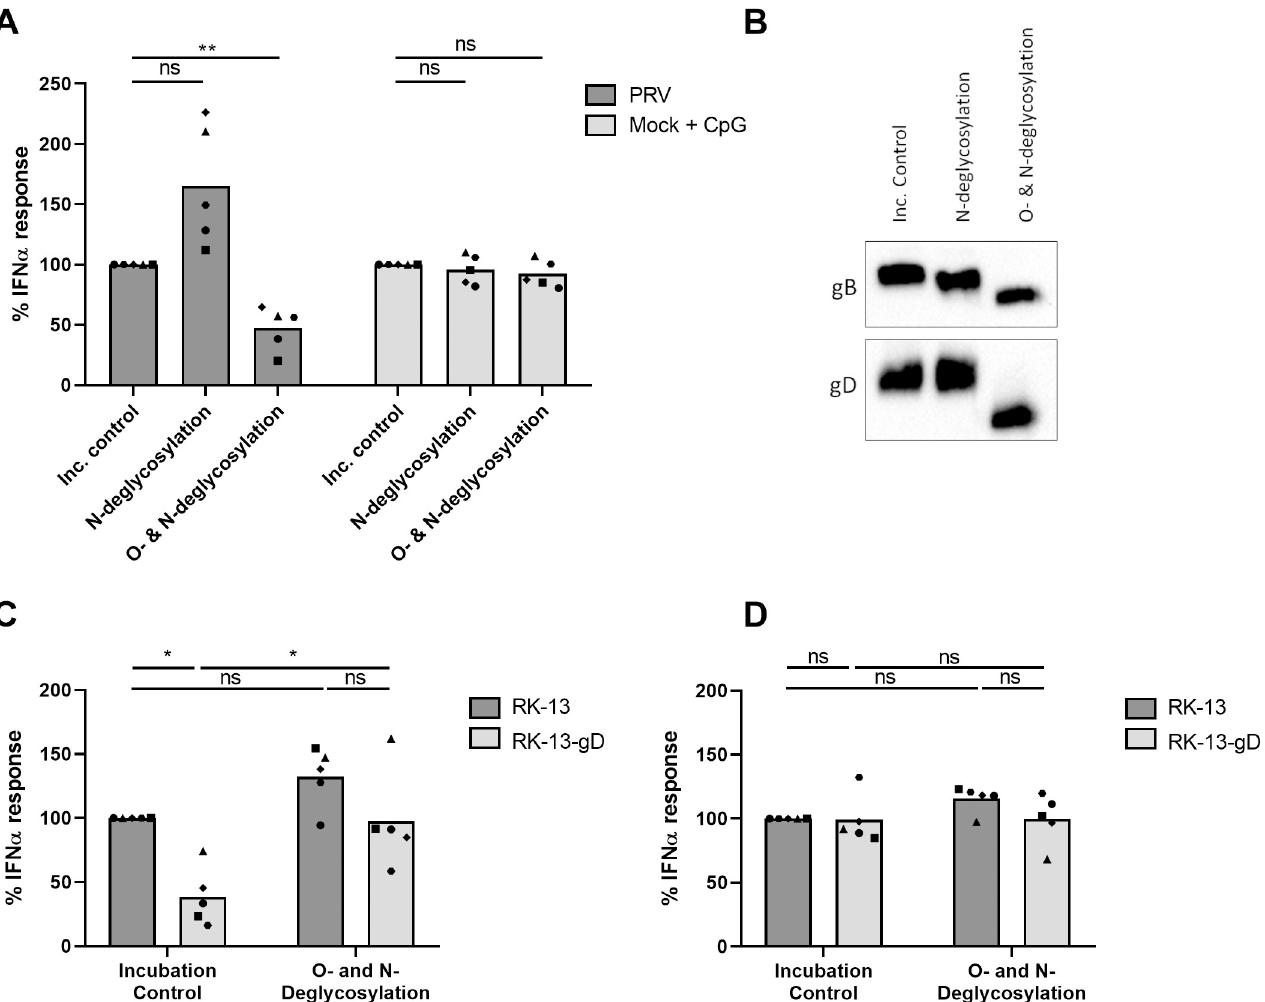
Fig 4. PRV gD-mediated activation of pDC depends on O-glycans. (A) Density gradient purified PRV H-particles or mock controls were incubated overnight at 37˚C with PNGase F (removing N-glycans), a deglycosylation mixture (removing both N- and O-glycans) or deglycosylation buffer only as a control and subsequently added to porcine PBMC for 22h. For the mock control, pDC were stimulated with CpG ODN. The measured IFN α responses are normalized to the buffer control without any enzyme (set to 100) for each of the five independent repeats. (‘ns’ not significant, ‘ �� ’ P < 0.01). (B) Western blot analysis of deglycosylated PRV H-particles. Antibodies against the viral proteins gB and gD were used. (C-D) Parental RK-13 cells or RK-13 cells stably expressing the PRV glycoprotein gD were incubated with a deglycosylation mixture (removing both N- and O-glycans) or PBS with 1% BSA only as an incubation control. Cells were subsequently added to porcine PBMC prior to the addition of density gradient purified PRV H-particles (C) or CpG ODN (D) for 22h. The measured IFN α responses are normalized to the response using incubation control parental RK-13 cells (set to 100) for each of the five independent repeats. (‘ns’ not significant, ‘ � ’ P <